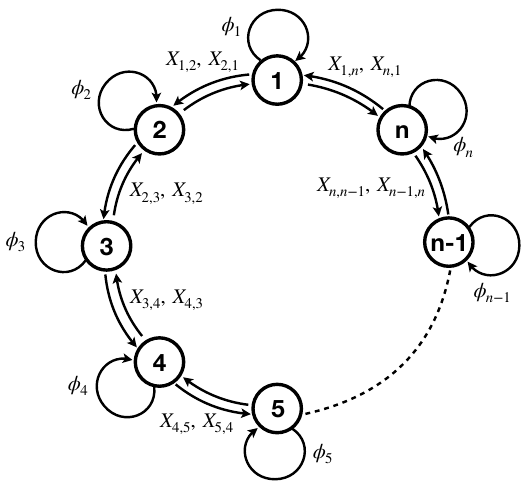
Figure 2 . Quiver diagram of an N = 2 necklace theory with n SU( N c ) gauge groups. The numbers in the circles are used to progressively label the SU( N convention throughout the paper.